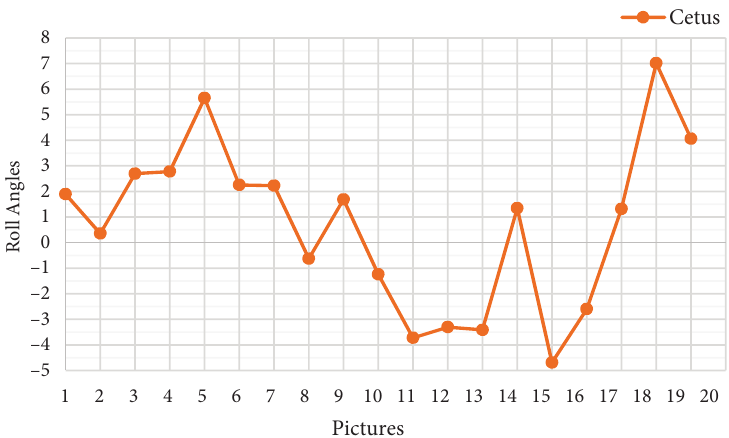
Figure 5. Values of “Cetus” UAV roll